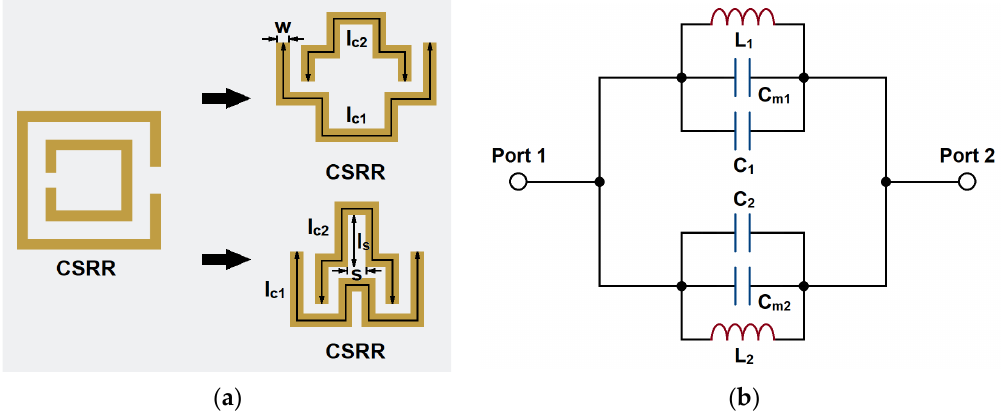
Figure 12. The shape modifications of the CSRR structure: ( a ) topology and ( b ) equivalent circuit model.